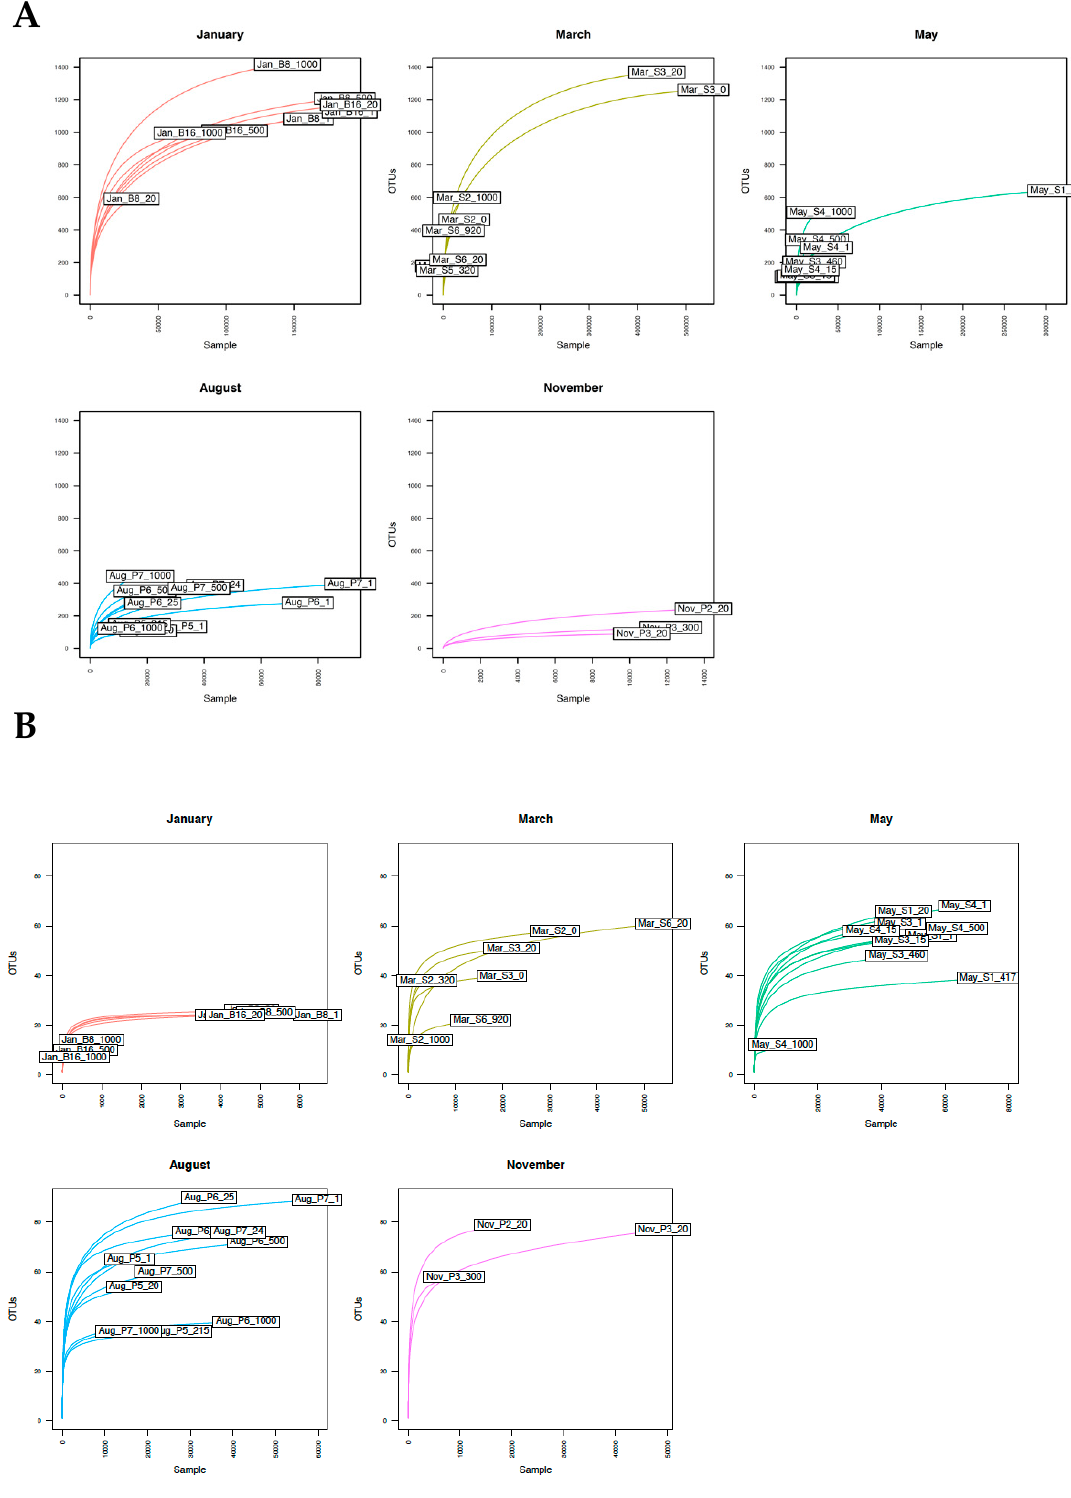
Figure 6. Rarefaction analysis of ( A ) g23 and ( B ) MCP OTU diversity. OTUs with a relative abundance >0.1% were included.